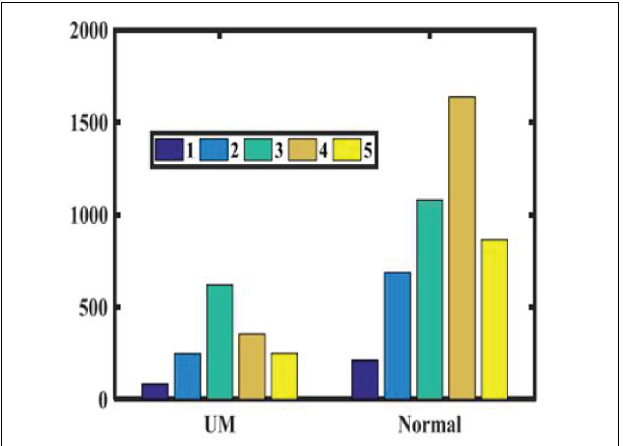
FIGURE 2 | Iris color grading of patients in two groups.